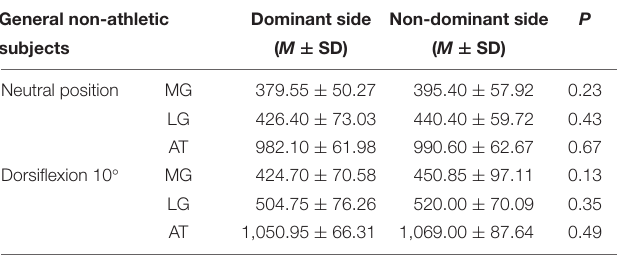
TABLE 3 | The stiffness of the MG, LG, and AT in the general non-athletic subjects.